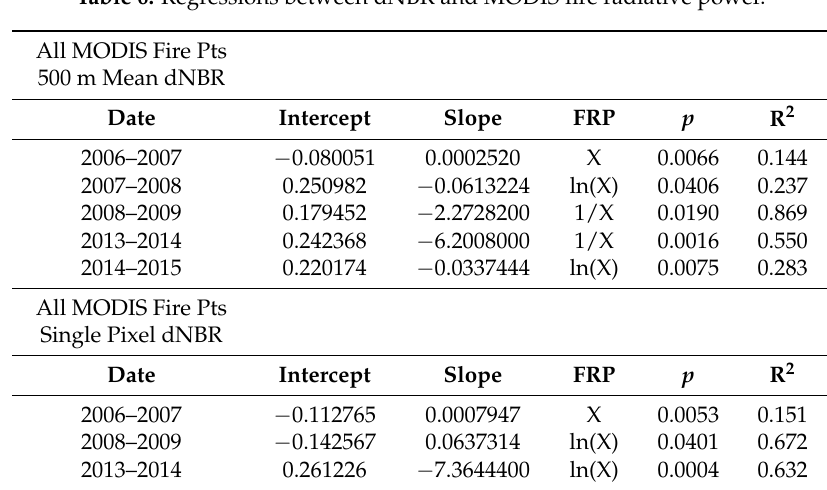
Table 6. Regressions between dNBR and MODIS fire radiative